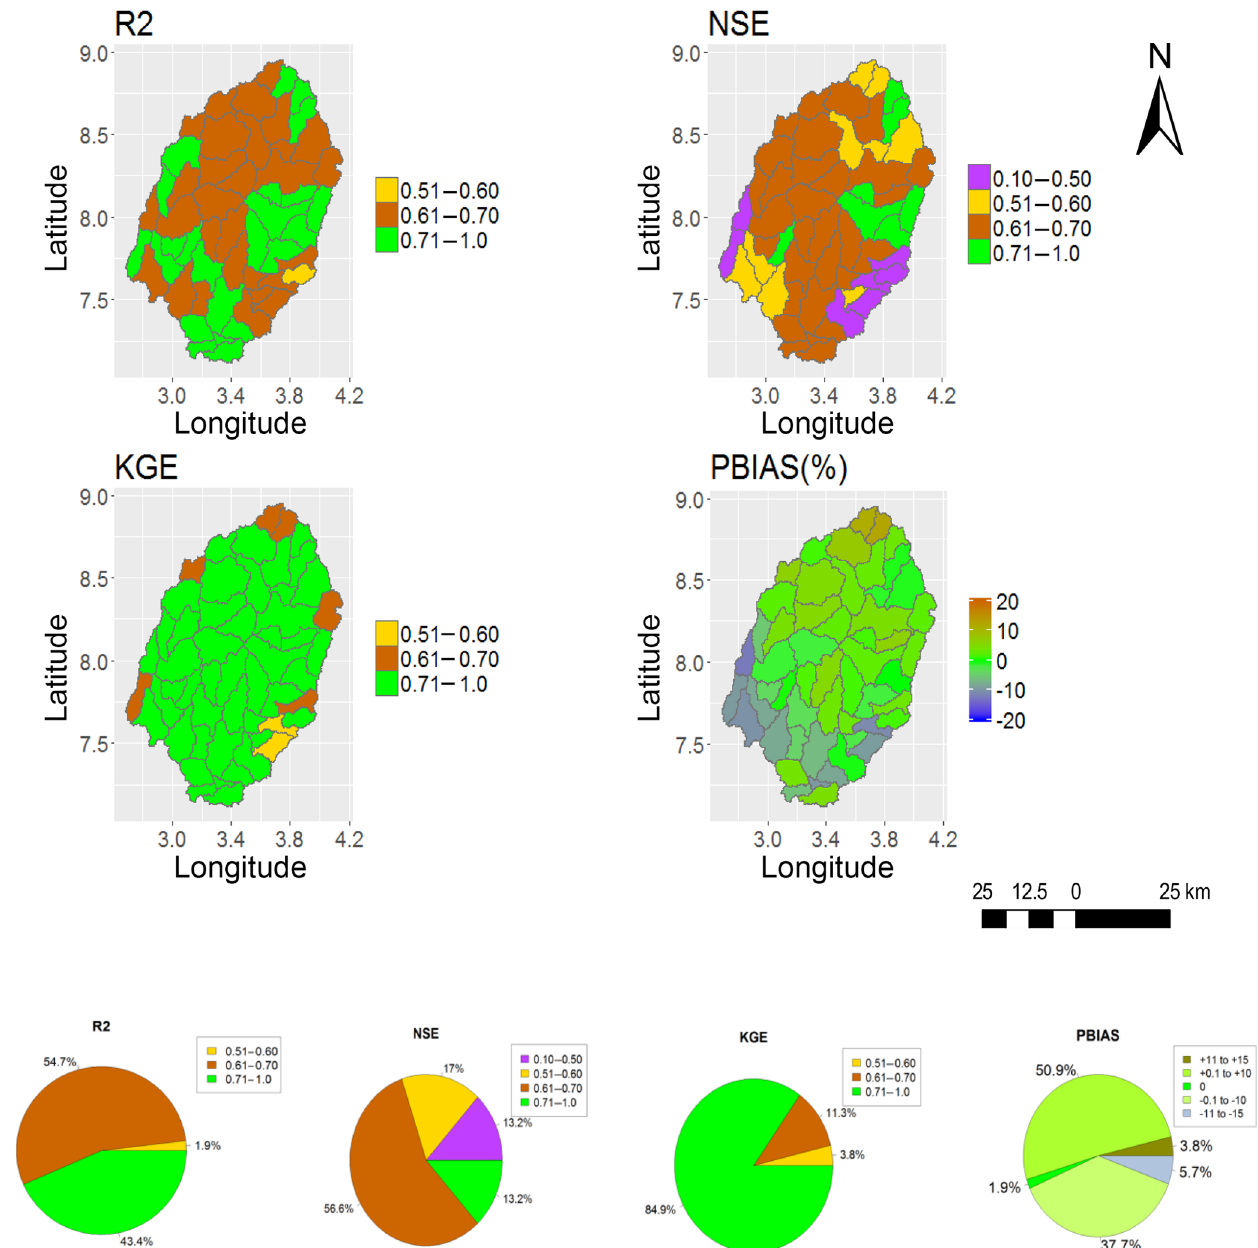
Figure 4. Performance metrics (NSE, KGE, R 2 and PBIAS) of SWAT (SWAT_HG) when calibrated with GLEAM_v3.0a